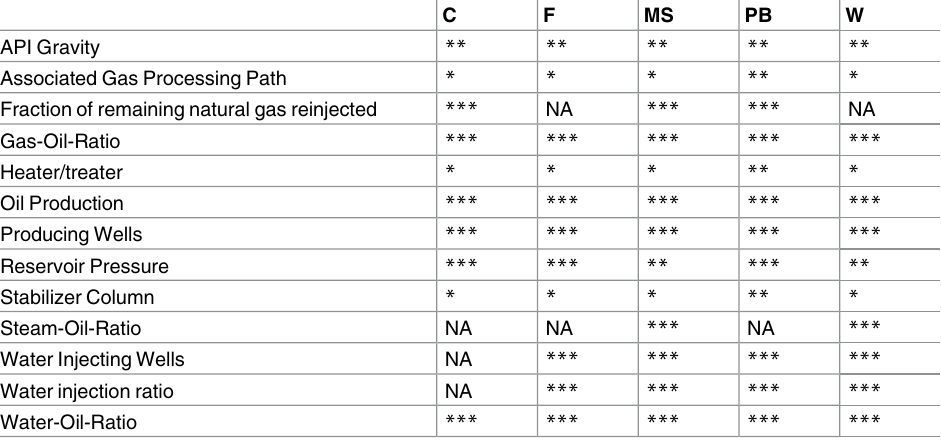
Table 4. Abbreviated data quality assessment (C = Cantarell, F = Forties, MS = Midway-Sunset, PB = Prudhoe Bay, W = Wilmington). * = Poor quality, ** = Moderatequality, *** = High quality.